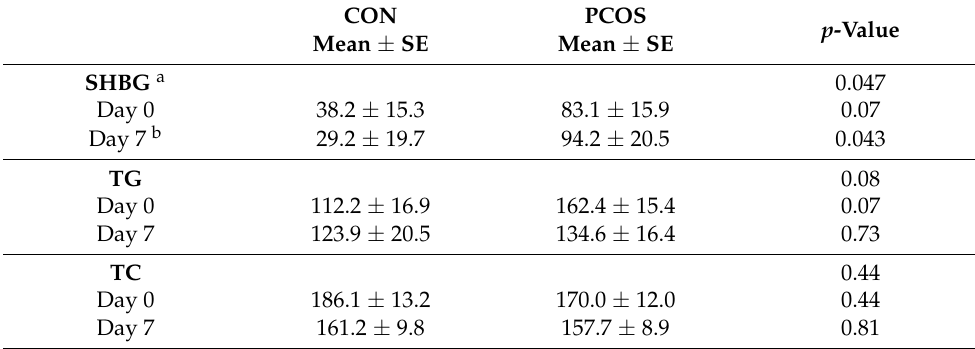
Table 5. Adjusted means and variability for SHBG, TG, and TC, with body fat percentage as a